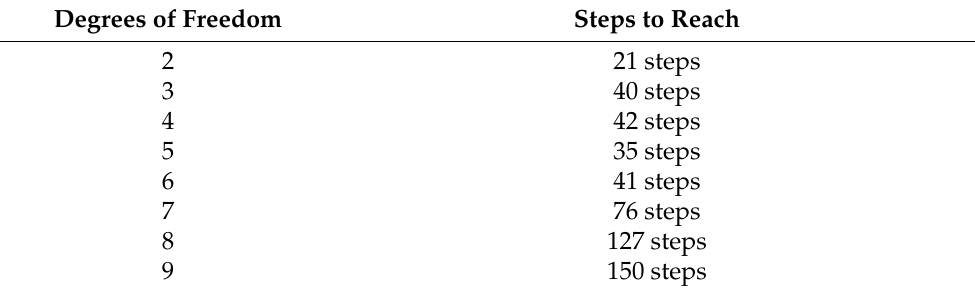
Table 2. Reaching steps for different degrees of freedom enabled.